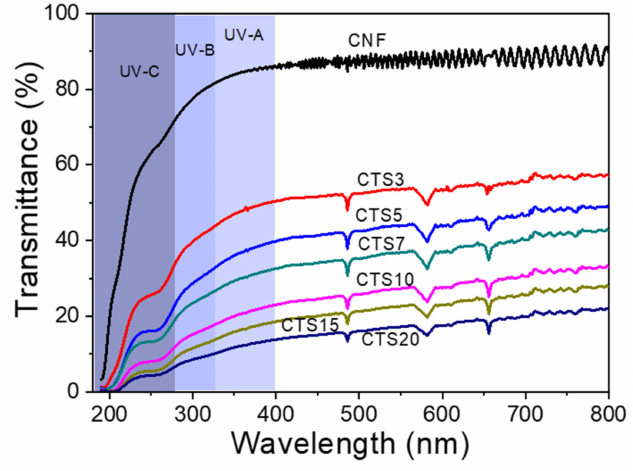
Figure 10. UV-transmittance of ChNF–CNF composites.